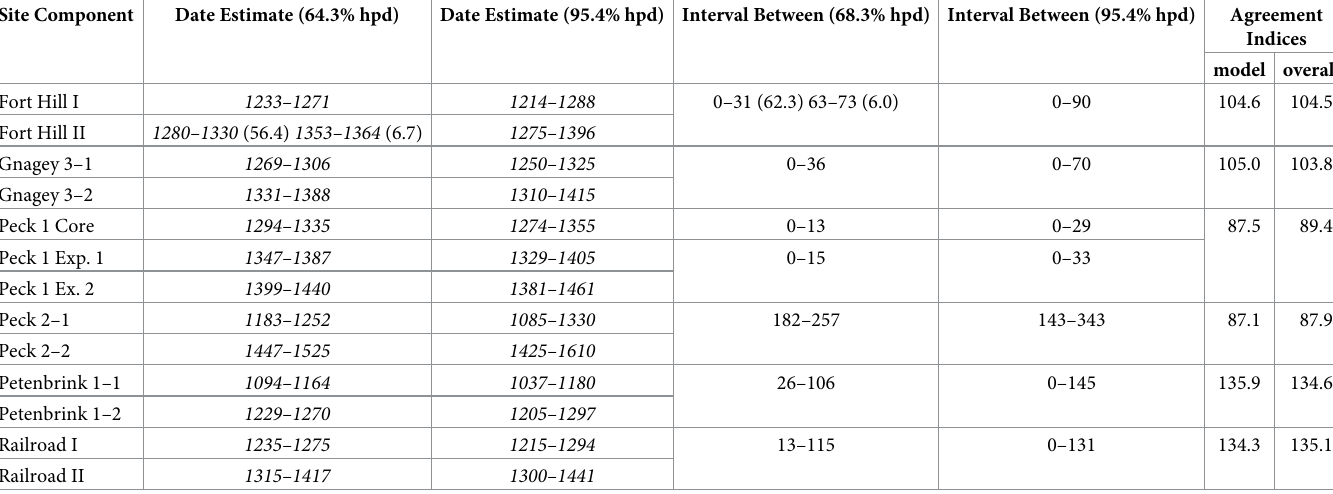
Site chronological ordering Site order probability matrices were calculated combining the results of the two subregional models for each interval constraint using the Order command with posterior probability data for Start Boundaries and Date estimates. A summary of the matrices is presented in Table 5 indicating the probability of each site being later in time than the preceding site. Detailed results are provided in S2 Table. The site orders between the different Interval constraints and Table 3. Date estimates of and intervals between site-specific sequential phases in the Allegheny Mountains section of the lower upper Ohio River basin. Site Component Date Estimate (64.3%